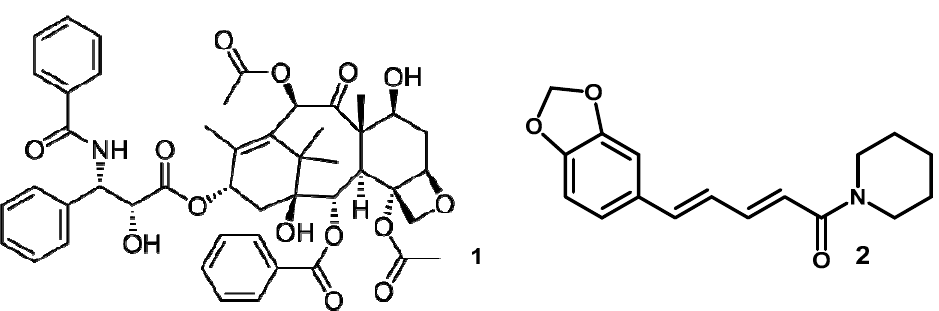
Figure 1. The chemical structure of taxol ( 1 ) and piperine ( 2 ) from the Periconia